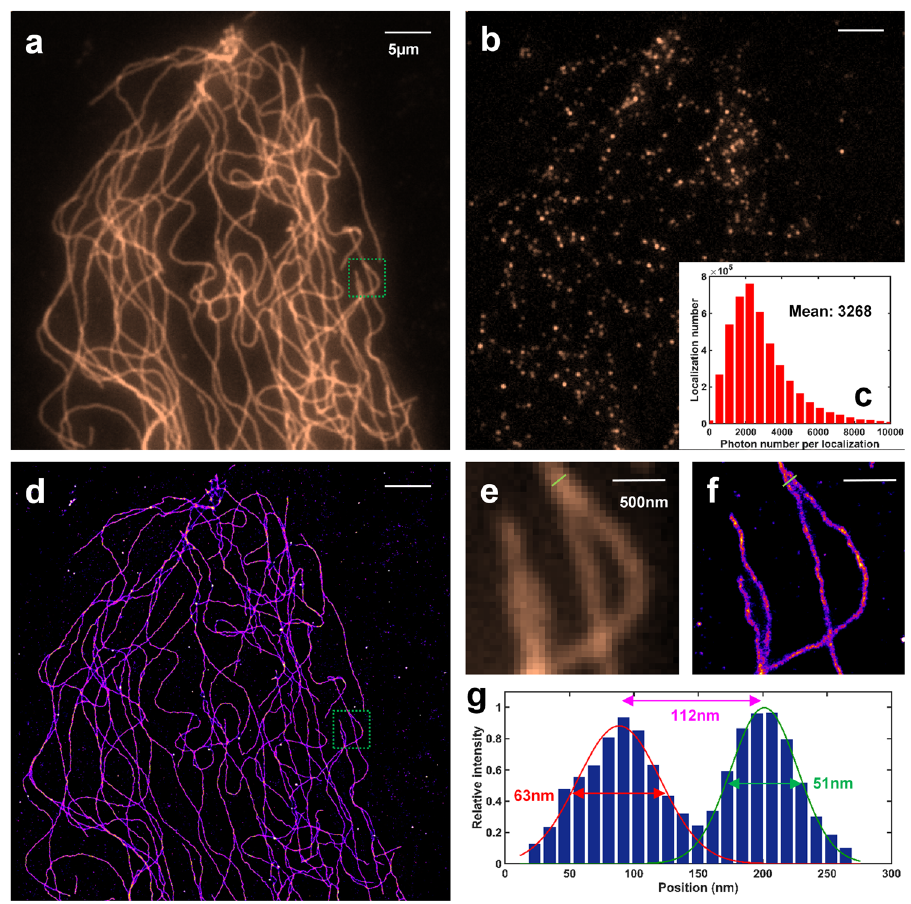
Figure 5. Performance of low-cost SMLM imaging of microtubules in MEF cells. ( a ) Conventional wide-field fluorescence image. ( b ) A single raw image under d STORM imaging condition. ( c ) Statistical distribution of the photon number per localization event in this experiment. ( d ) The reconstructed super-resolution image. Pixel size: 11.5 nm. ( e , f ) are the zoomed-in region of the green box in ( a , d ). ( g ) Statistical distribution of the localization events along the green line in ( f